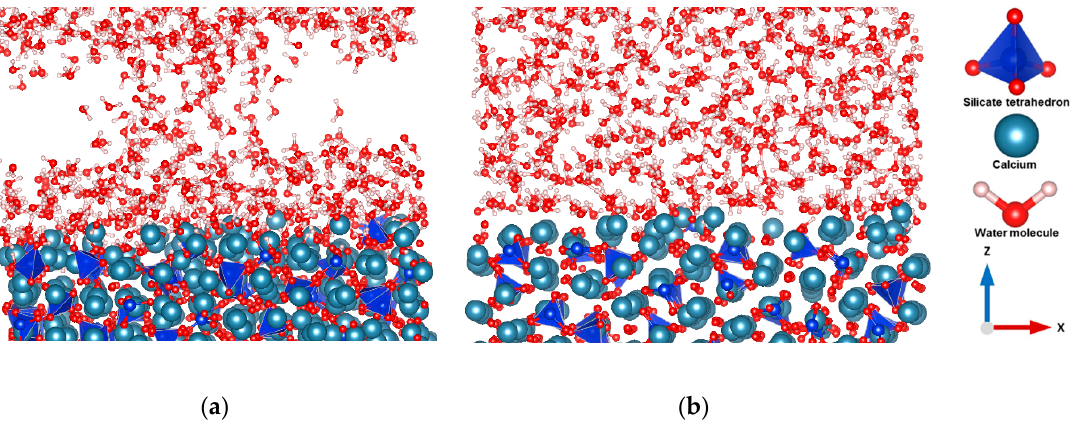
Figure 1. Comparison of the reactivity between the (011) surface and (001) ( a , b ) during hydration for 600 picoseconds at 298 K.